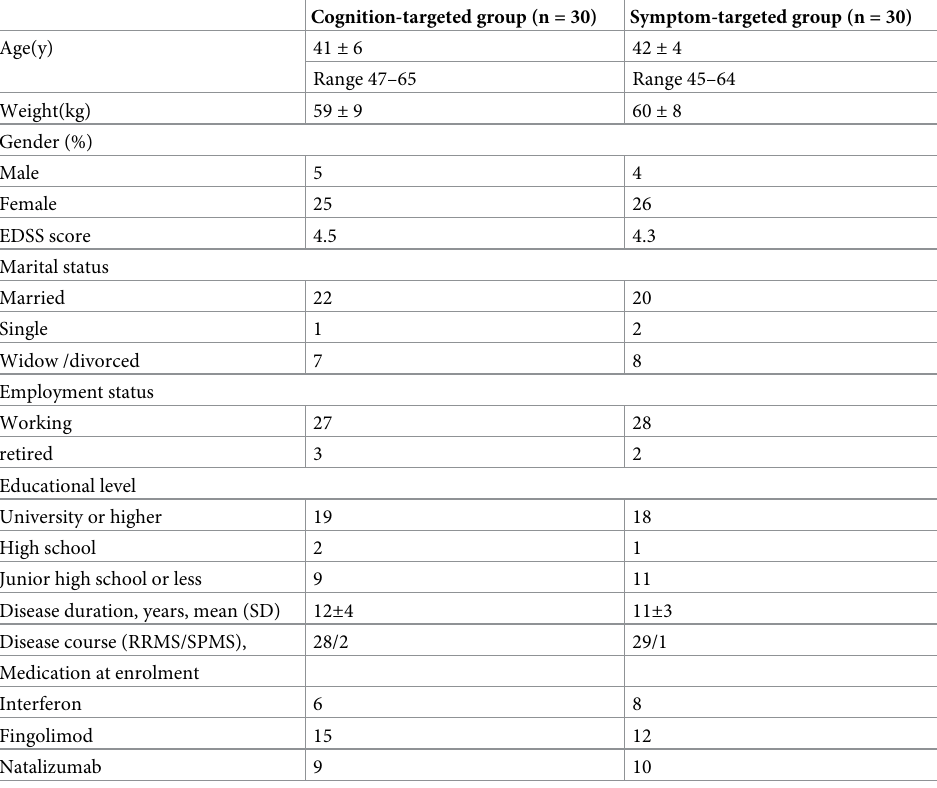
Table 2. Baseline participant